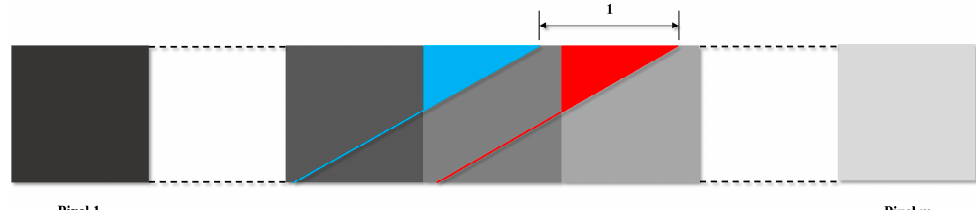
Figure 6. The subpixel edges (represented by red and blue) under two bands with offset of 1 in a row of the abundance map. of the abundance